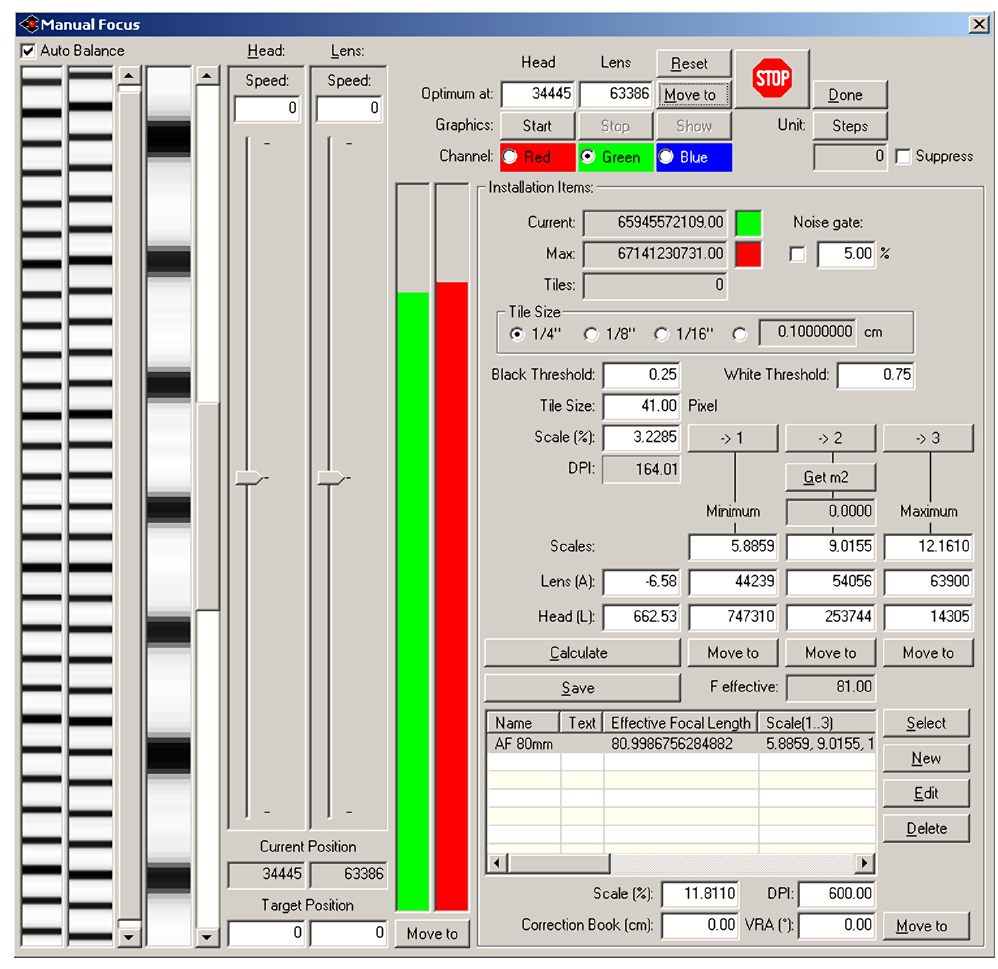
Figure 8. Cruse manual focus dialog for the focused picture.